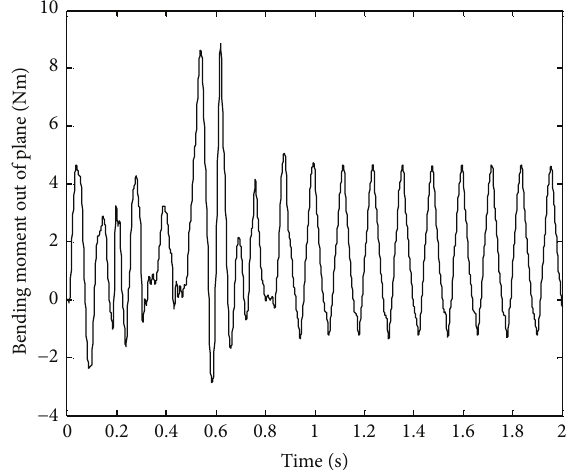
Figure 12: Bending moment at the blade root location.